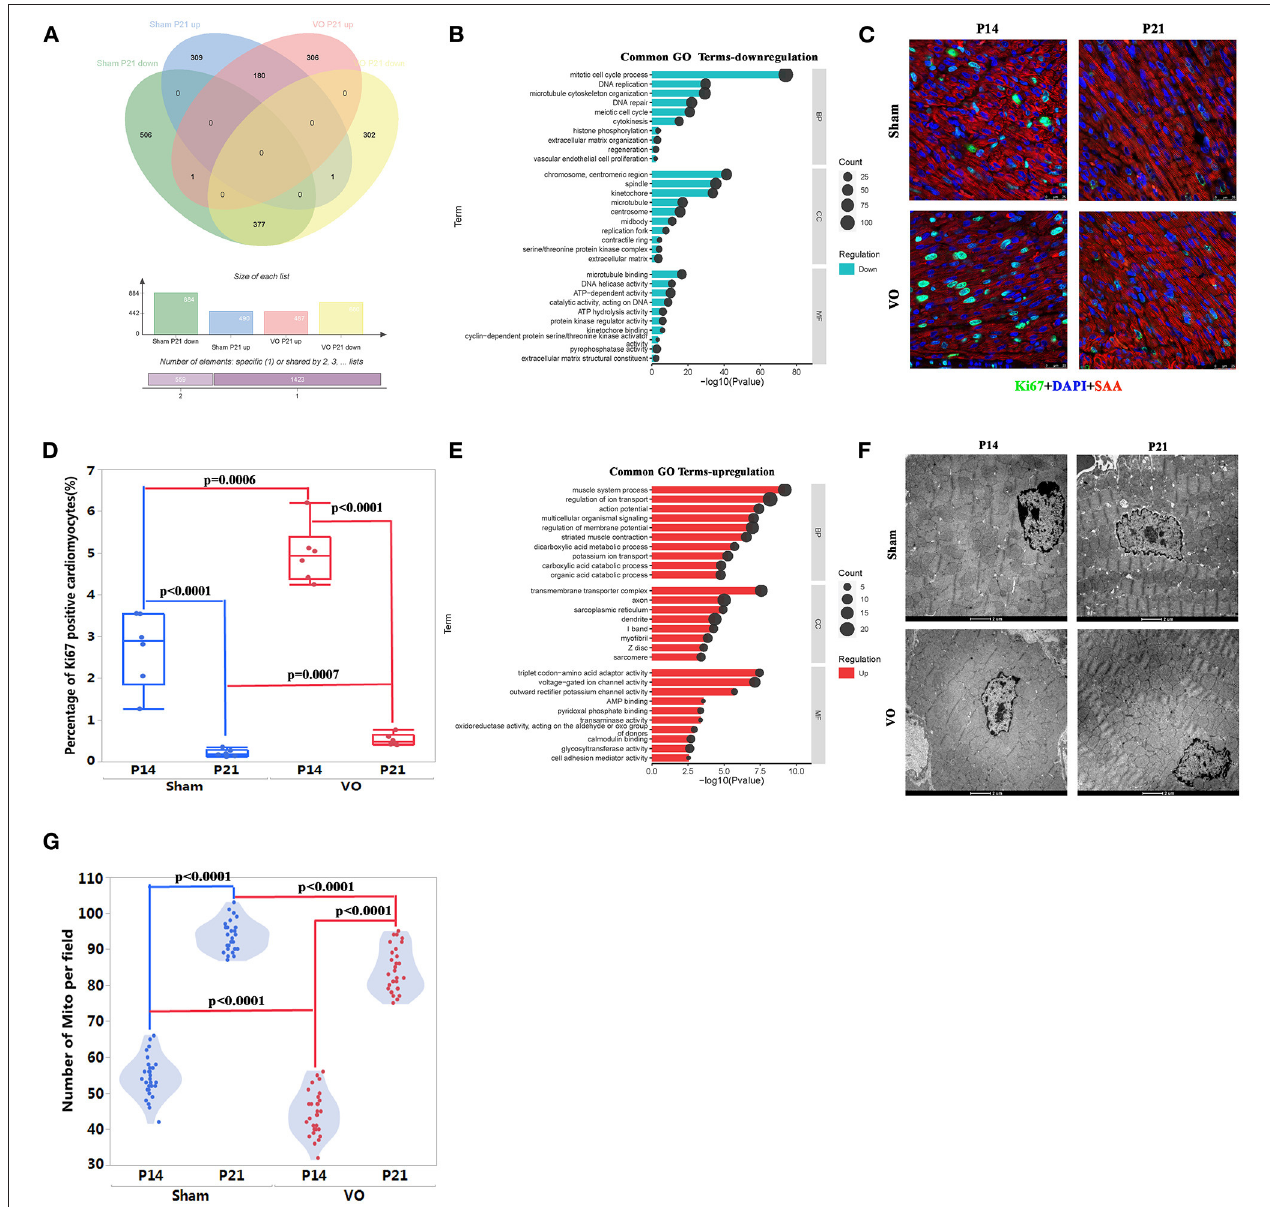
FIGURE 4 | The common developmental processes between normal and volume overload (VO)-influenced left ventricles (LV). (A) The Venn analysis of differentially expressed genes (DEGs) in the two comparisons. There were 377 downregulated and 180 upregulated genes in common between the Sham comparison (P21_Sham vs. P14_Sham) and VO comparison (P21_VO vs. P14_VO), where 309 upregulated genes and 506 downregulated genes only appeared in the Sham comparison, and 306 upregulated genes and 302 downregulated genes only appeared in the VO comparison, respectively. (B) The common 377 downregulated genes were subjected to Gene Ontology (GO) enrichment analysis. The top 10 terms are displayed. The abscissa is the GO term, and the ordinate is the significance level of GO term enrichment. The higher the value, the more significant the result. The size of the dots represents the number of genes annotated to the GO term. BP, biological process; CC, cellular component; MF, molecular function. (C) Representative Ki67-positive cells. Ki67 (green); DAPI (blue); sarcomeric α -actinin (SAA, red). (D) Quantification of Ki67-positive cardiomyocytes. (E) The common 180 upregulated genes were subjected to GO enrichment analysis. (F) Representative